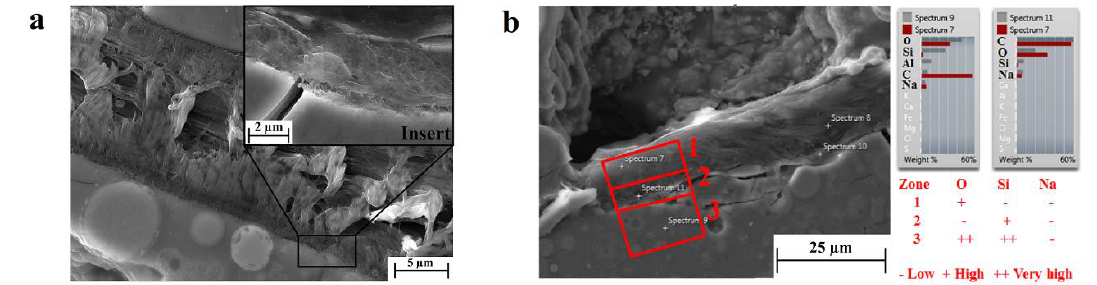
Figure 4. ( a ) SEM image of a cellulose–geopolymer interface, including a close-up of the new phase (insert), and ( b ) Energy-dispersed X-ray spectroscopy (EDS) analysis of the three zones of interest.